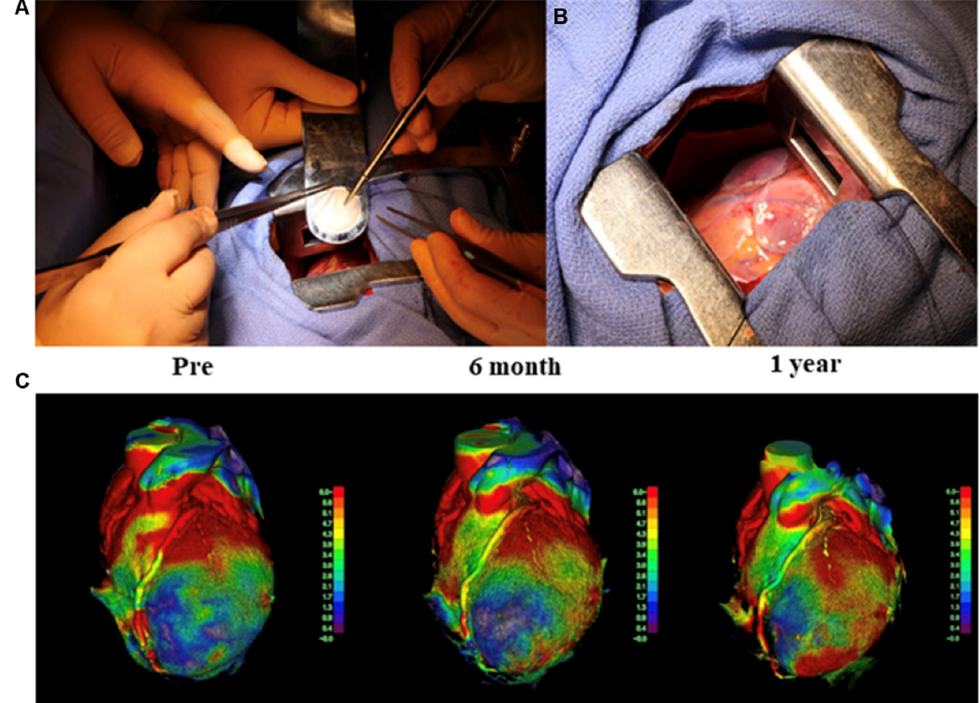
Figure 3. Transplantation of human induced pluripotent stem cell-derived cardiomyocyte (hiPSC- CM) sheet on the heart of a patient, as well as the cardiac movement pattern before and after surgery. ( A , B ) First transplantation of hiPSC-CM patches onto the heart surface of a patient with severe cardiomyopathy. ( C ) The moving pattern observed via four-dimensional CT. Reproduced with permission from Miyagawa et al. [89,90]. Copyright 2022, the